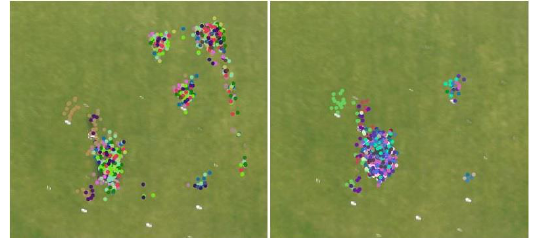
Figure 12. Frame of the thermal detection (left) and of the combined detection (right), taken from the result of the “Big Group Pass-through” scenario.